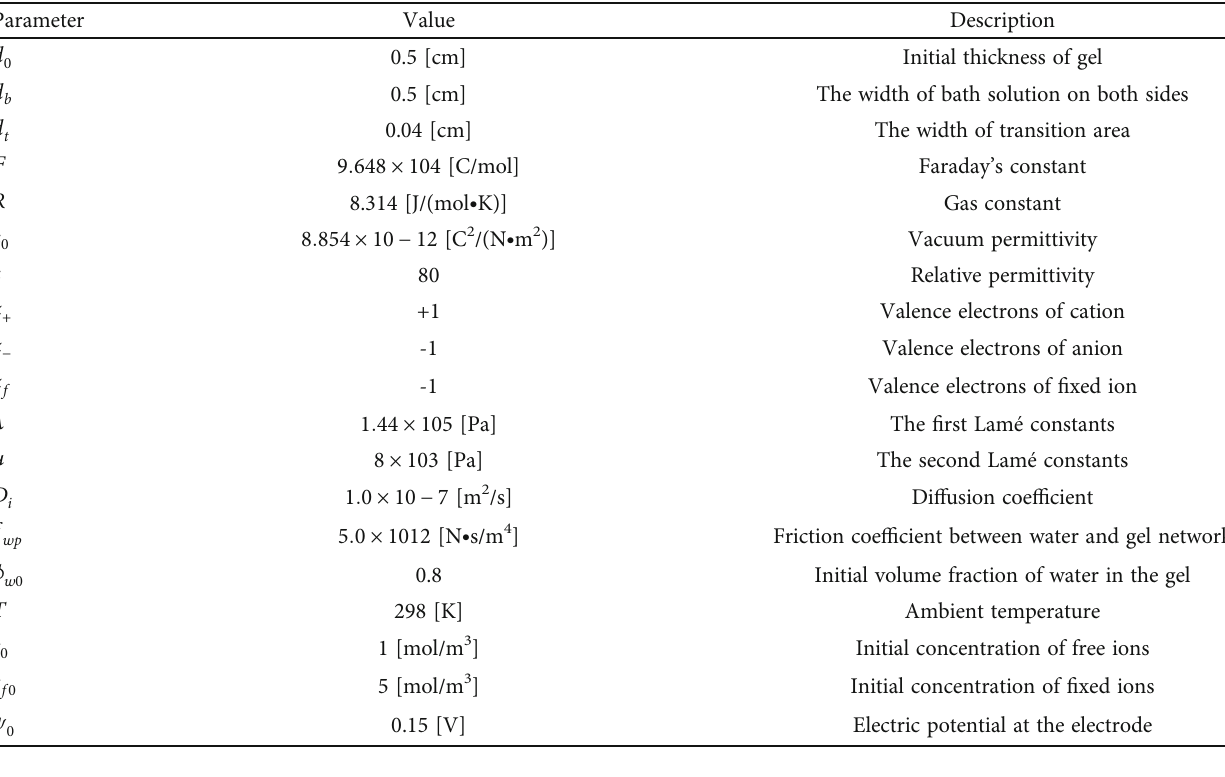
Table 2: The parameters for